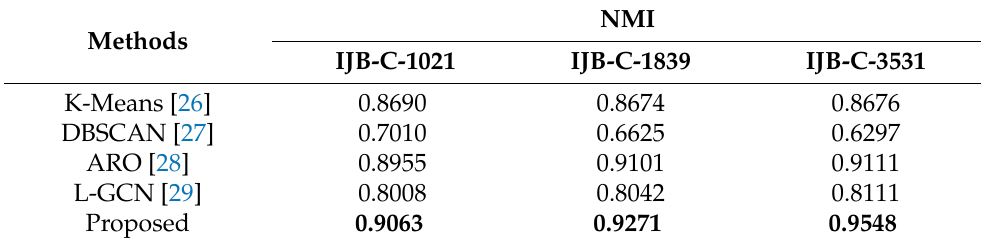
Table 6. Method comparison on the three subsets of